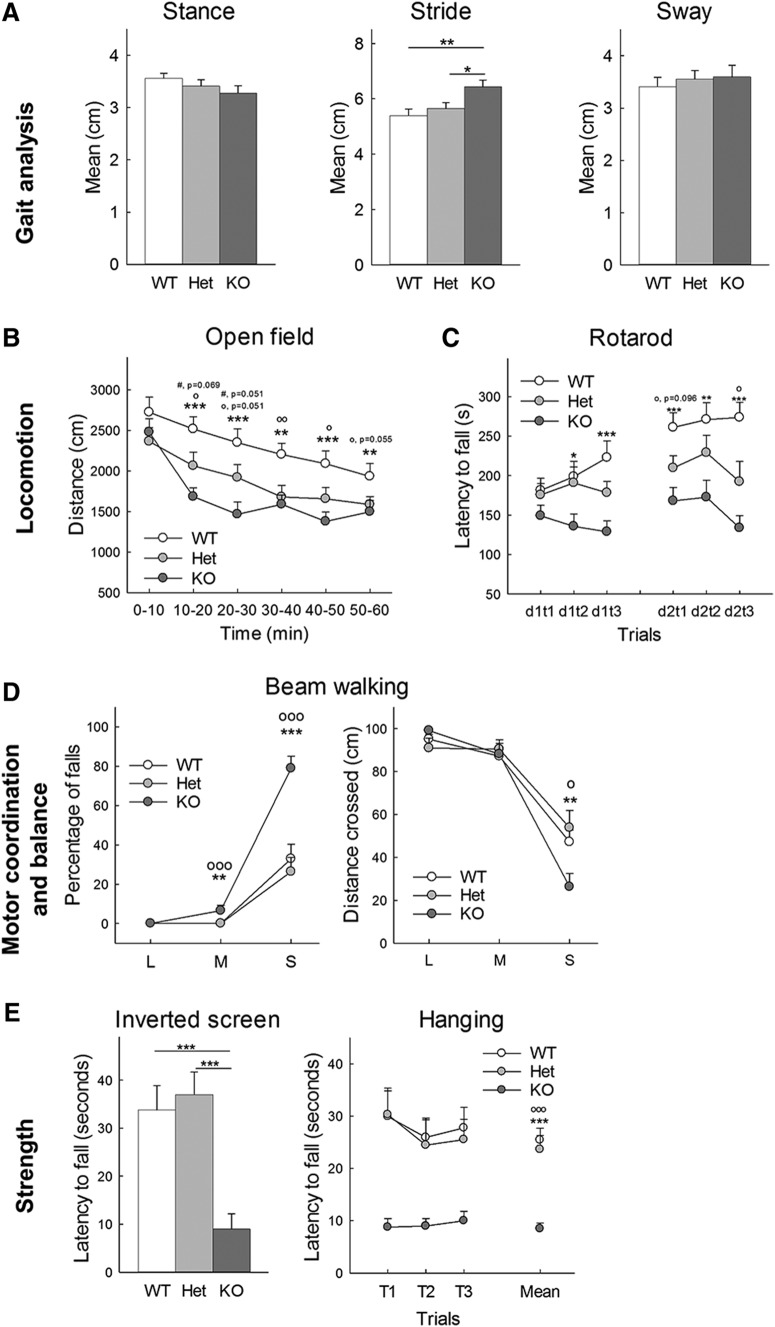
Impaired motor performances in in Shank3Δ4-22-deficient mice. A, Average stance, stride, and sway. Gait analysis showed an increase stride length in Shank3Δ4-22 homozygous mice. B, Distance traveled during a 60-min session in an open field. Spontaneous locomotor activity in the open field was reduced in Shank3Δ4-22 homozygous mice relative to other genotypes. C, Latency to fall over six trials (three trials per day for two consecutive days) in the accelerating rotarod task. Motor learning on the accelerating rotarod was deficient in Shank3Δ4-22 homozygous mice compared to wild-type animals as they failed to improve over time. Heterozygous mice had an intermediate phenotype. D, Percentage of falls and distance crossed during the beam walking test. While not different on the large (L, 1 inch) and medium (M, ½ inch) beams, Shank3Δ4-22 homozygous mice were strongly impaired in the small (S, ¼ inch) beam walking test, as shown by a significant increase of the number of falls and a decrease of the distance crossed. E, Strength and endurance measured in the inverted screen and hanging tests. Endurance strength was significantly impaired in Shank3Δ4-22 homozygous mice as they exhibited significantly shorter latency to fall in both the inverted screen and hanging tests. Additional results of motor tests (hindlimb placing and grip strength) are available in Extended Data Figure 3-1. WT, wild-type mice; Het, heterozygous mice; KO, homozygous knock-out mice. *: WT versus KO; o: WT versus Het, #: Het versus KO. *p < 0.05, **p < 0.1, ***p < 0.001.